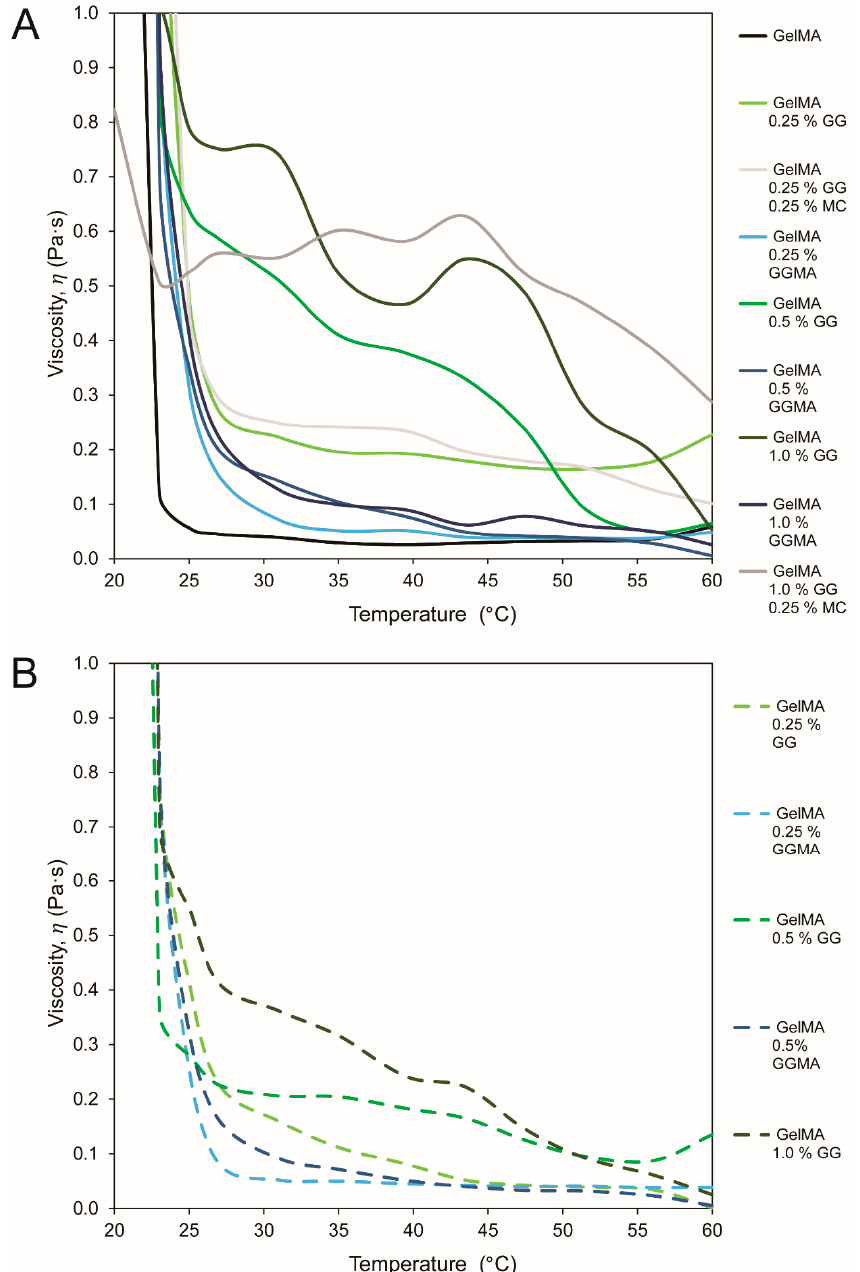
Figure 3. Rheological measurements of viscosity of blended hydrogels. Viscosity of blended hydrogel groups, over the temperature range of 60–20 °C, with ( A ) PBS groups; and ( B ) NaCl + mannose groups. Colors are shared between PBS and NaCl + mannose gel groups, with the latter indicated by dashed lines. n = 1 in all cases.